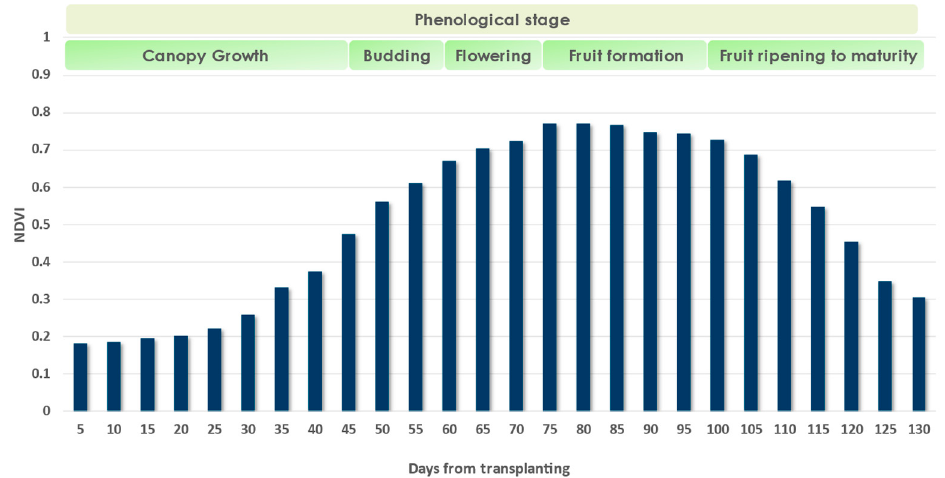
Figure 5. Annual NDVI dynamics and the respective phenological stages of the processing tomato crop.